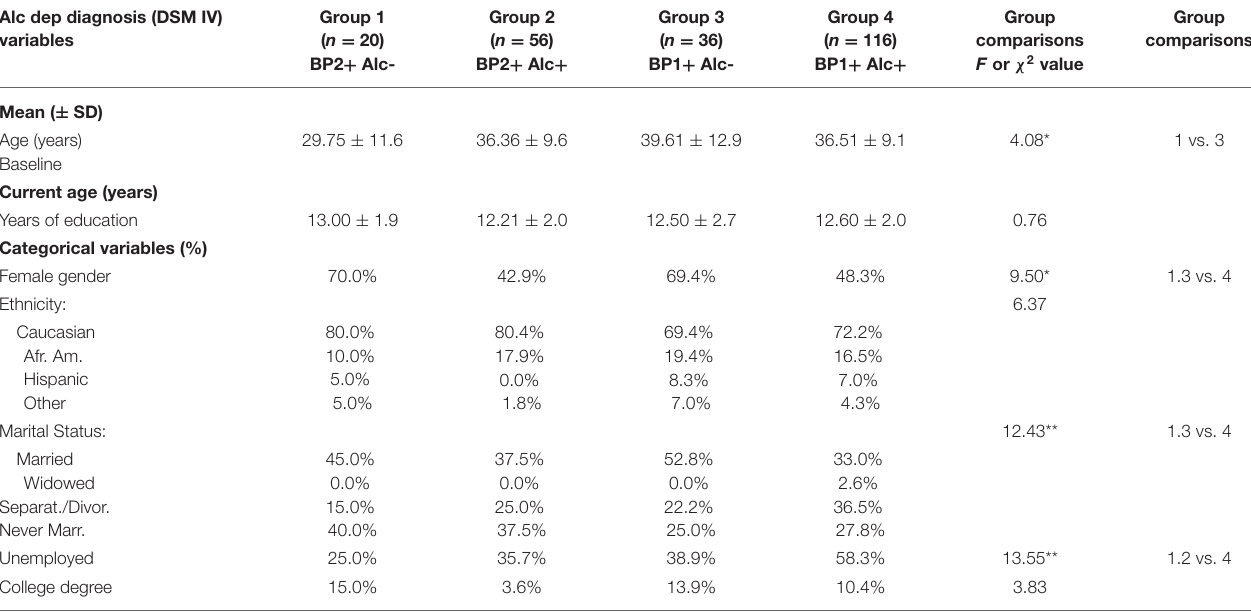
TABLE 1 | Baseline Demographic Characteristics of Bipolar 1 and 2 Subjects Divided by Alcohol Dependence Diagnosis. Alc dep diagnosis (DSM IV) variables